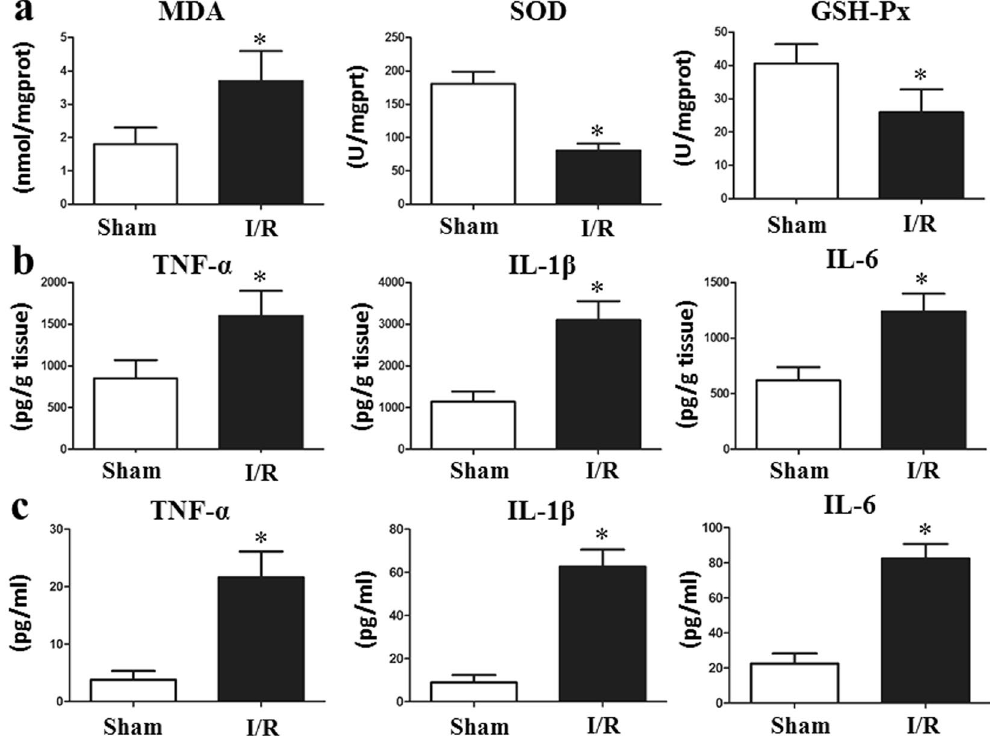
Figure 2. Total intestinal I/R causes oxidative stress and inflammation in vivo . ( a ) The levels of SOD and GSH-Px were significantly decreased, and the MDA level was markedly increased in the I/R group compared with that in the sham group. Both the tissue ( b ) and serum ( c ) IL-1 β , IL-6 and TNF- α levels production were found to be markedly increased after only two hours of intestinal I/R. The Data were expressed as means ± SD. * p < 0.05 vs the I/R group.